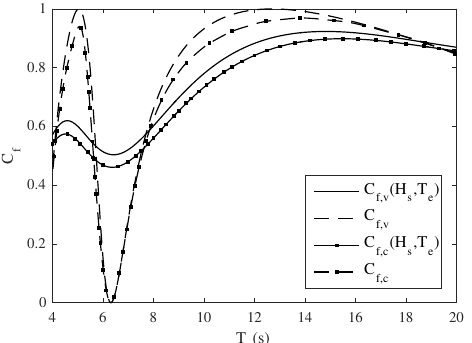
Figure 14. Spectral performance of the plant (solid lines indicate spectral C f and the dashed lines show the C f of a regular wave).